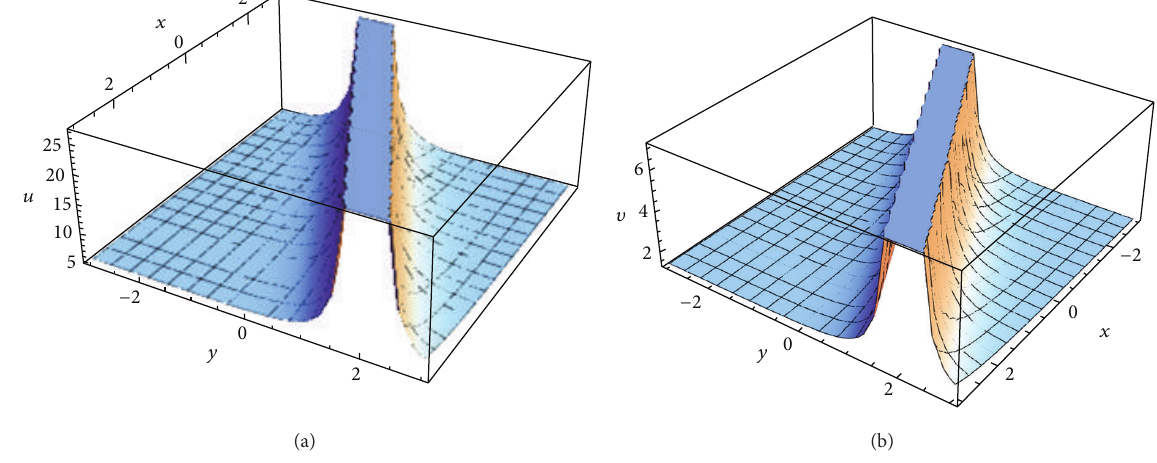
Figure 1: Profile of the travelling wave solution ((13a) and